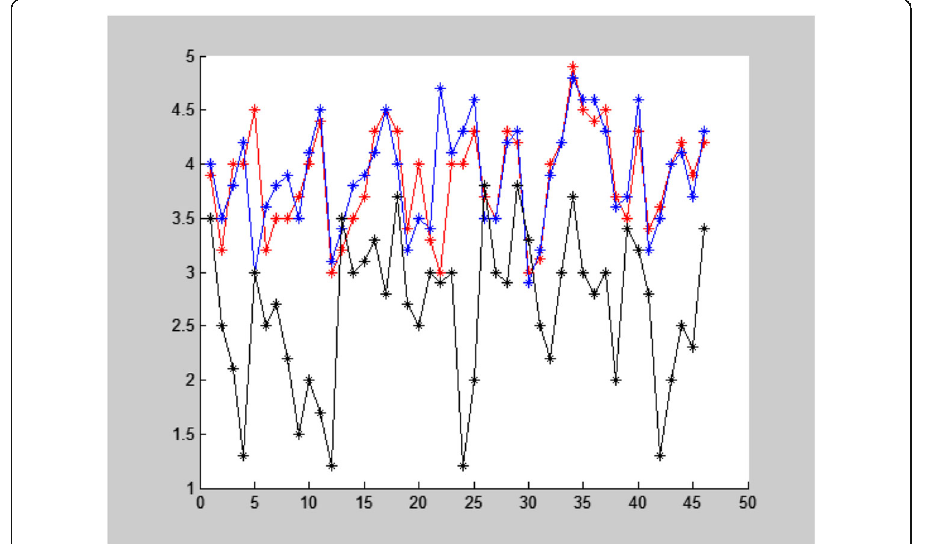
Fig. 4 Sample plot of the DWSVM